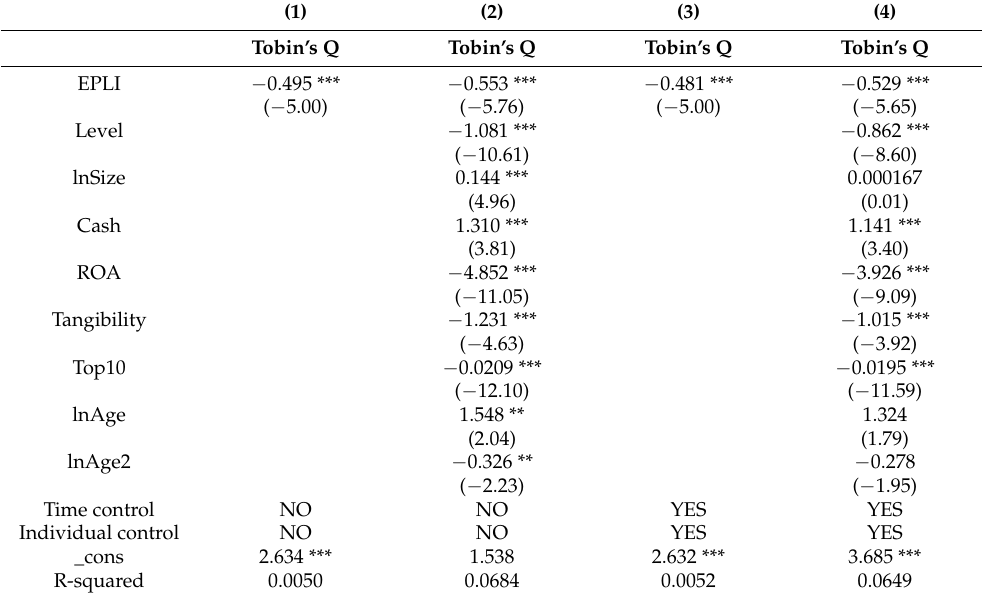
Table 4. The impact of EPLI on corporate